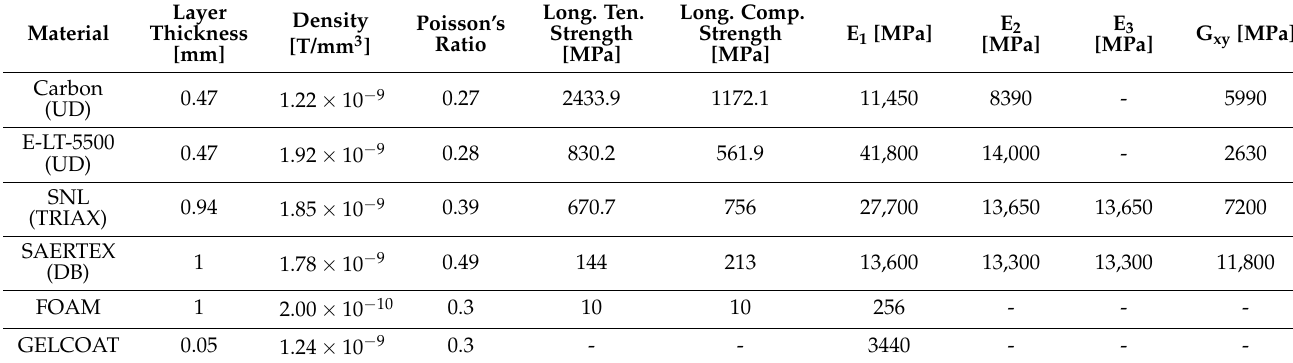
Table 1. Mechanical properties.